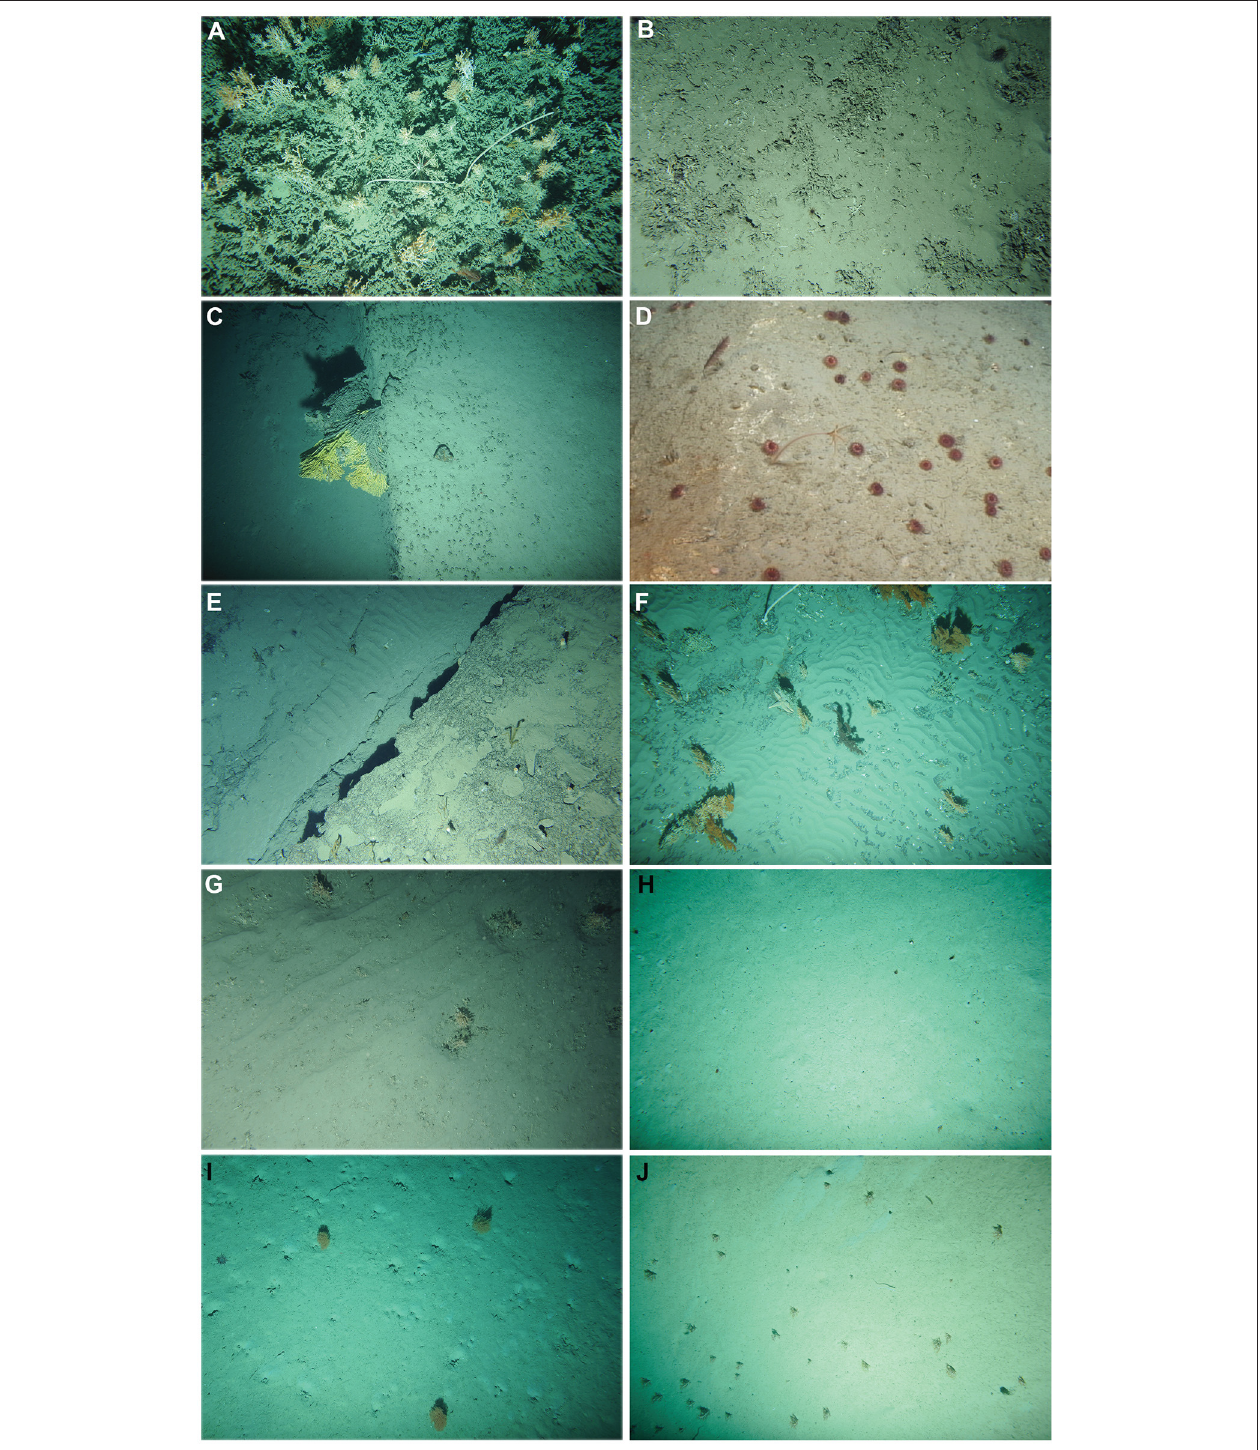
FIGURE 2 | Example images of the coral habitats of the Bay of Biscay: (A) Coral reef (BobGeo 2009), (B) Coral rubble (Evhoe 2012), (C) Colonial scleractinians on hard substrate (Evhoe 2011), (D) Solitary scleractinians on hard substrate (BobEco 2011), (E) Antipatharians or gorgonians on hard substrate (Evhoe 2012), (F) Mixed corals on hard substrate (Evhoe 2009), (G) Colonial scleractinians on soft substrate (Evhoe 2012), (H) Solitary scleractinians on soft substrate (Evhoe 2011), (I) gorgonians on soft substrate (BobGeo 2009) and (J) Seapens on soft substrate (Evhoe 2010). Mixed corals on soft substrate is formed by the same species as (I,J) ; therefore, a representative image of this habitat is not added. Copyright of all images in this figure: Ifremer. Ifremer provided permission for reproduction.